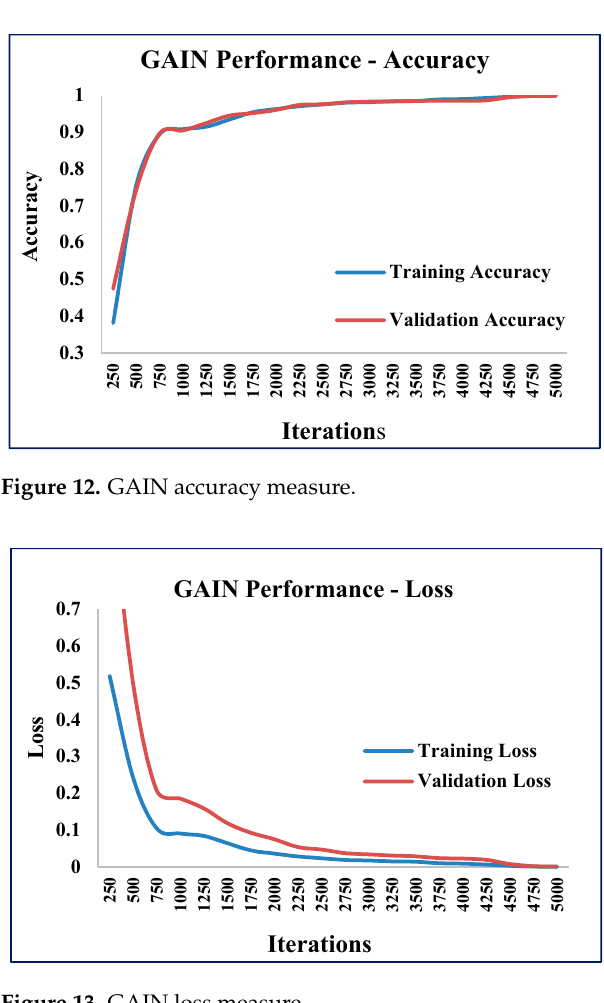
Figure 14. GAIN overall performance. As the iterations increased, the validation accuracy also increased, and the validation loss decreased. The training and validation accuracies reached the maximum (Figure 12) and stabilized as the iterations increased. The training and validation losses reached the minimum (Figure 13) as the iterations increased.